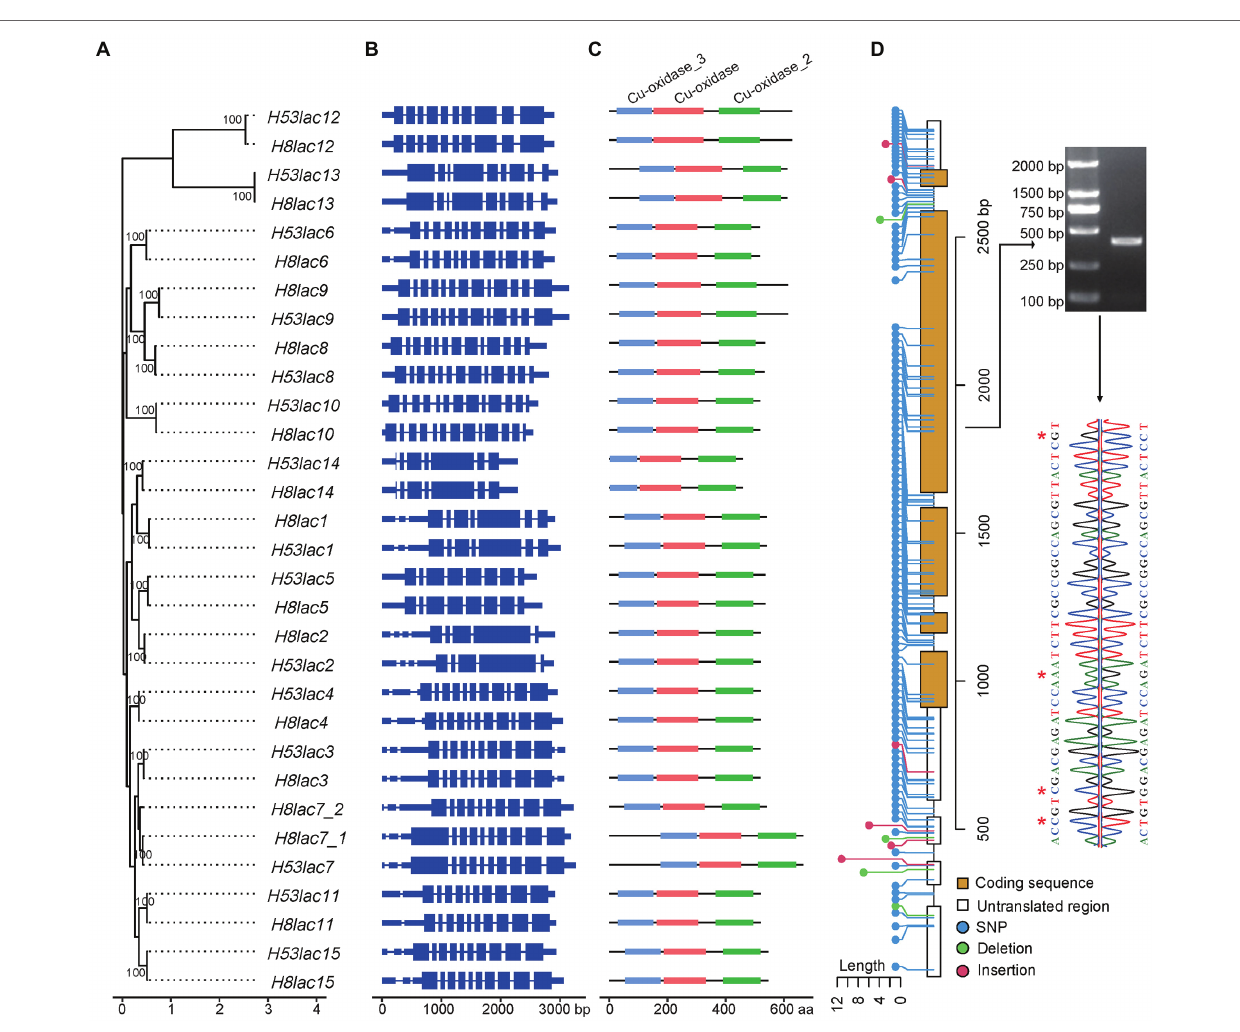
(C) Cu-domain. (D) Genetic variations, agarose gel electrophoresis, and Sanger sequencing of Gllac2 . Red stars represent SNP